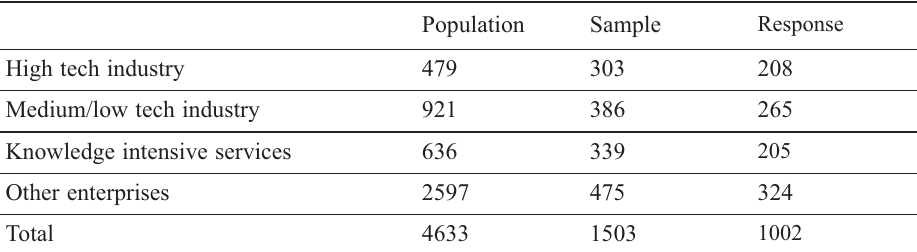
Table 3. Design of the International outsourcing survey (number of fi rms)